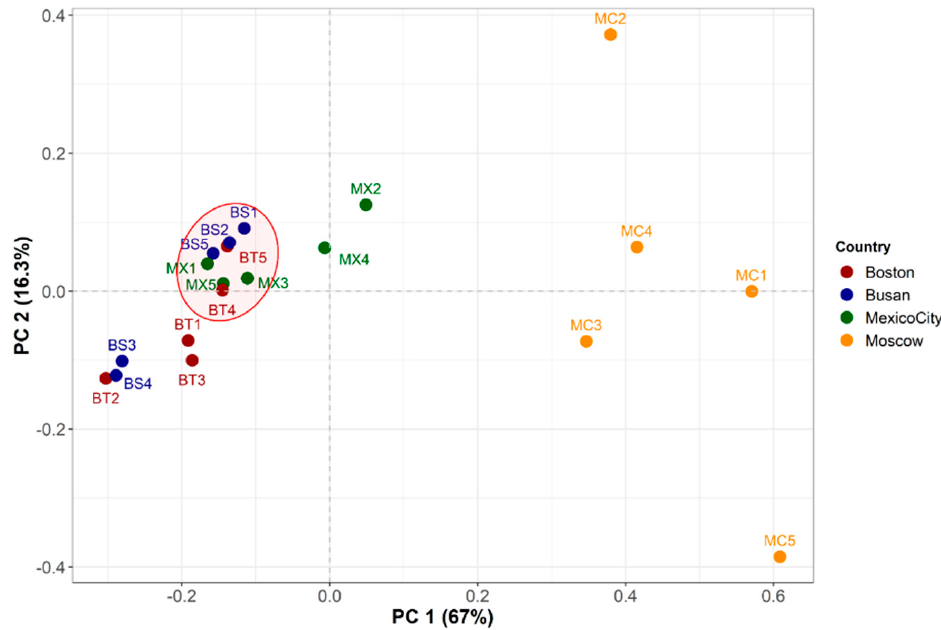
Figure 3. Principal coordinate analysis (PCoA) plot of bacterial compositions in global subway samples. Blue: Busan, Red: Boston, Green: Mexico City, Orange: Moscow. According to Upset plot results, the number of identified genera was in the order of Boston, Busan, Mexico City, and Moscow (Figure 4). All samples shared 75 genera, while three cities, Busan, Boston, and Mexico City shared the most genus with 486 (Figure 4). As shown at the alpha diversity (Figure 1) and beta diversity (Figure 3), the uniqueness of Moscow microbial community is well represented in the upset plot at the genus level. The number of identified genus is around 1000 each in Busan and Mexico City, whereas only 100 in Moscow (Figure 4A). However, the small data set of the Moscow subway station genera is not unique to our study. An existing study, which was the source of the Moscow